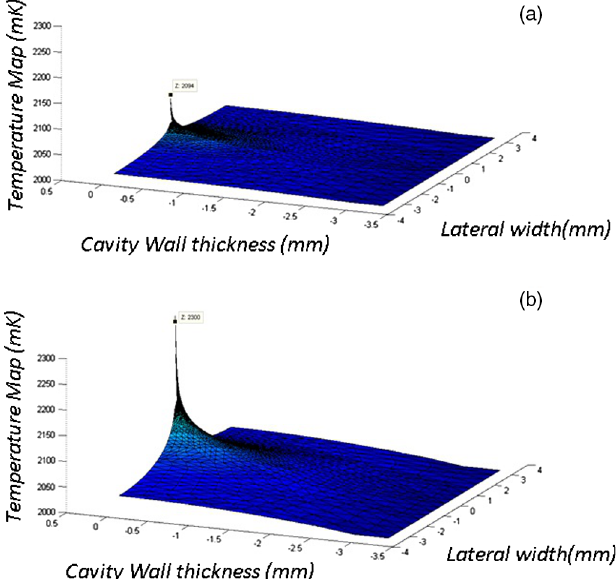
FIG. 10. Temperature maps calculated for applied magnetic field of (a) 100 mT and (b) 120 mT with the isolated 100 μ m rough strip from Fig. 8. The maximum temperature reaches 2.094 and 2.300 K, respectively. The helium bath condition is 2.00